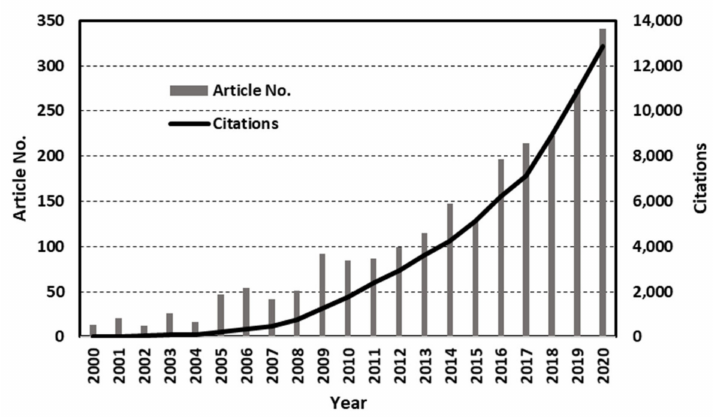
Figure 1. Number of articles (Article No.) and related citations regarding PMRs from the year 2000 to 2020 documented in the Scopus database (keywords: “photocatalytic membrane reactor” or “membrane photoreactor” or “photocatalytic membrane”).